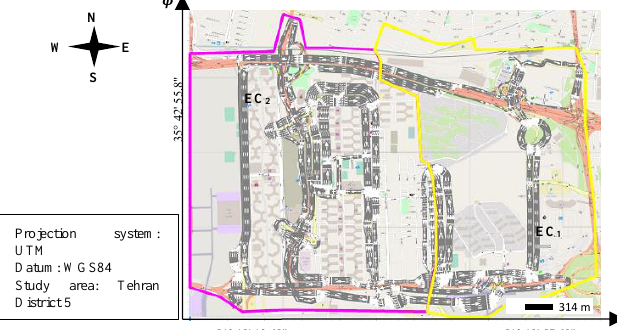
Figure 5. The SA optimization result of AMWNVDs for